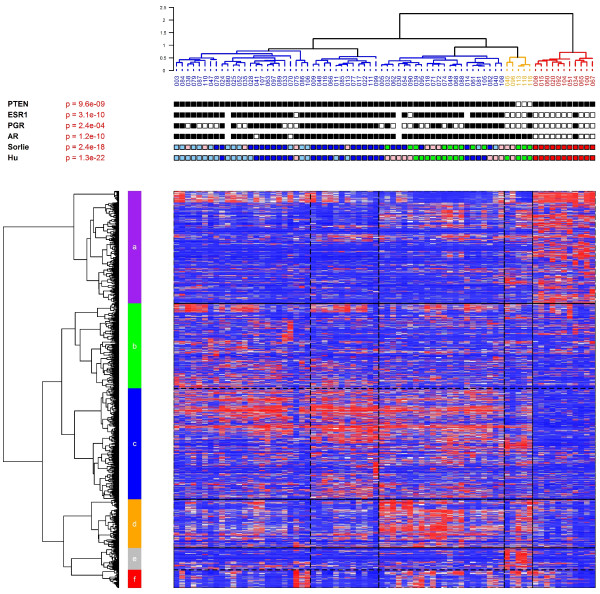
Unsupervised hierarchical clustering of familial breast cancers. Unsupervised hierarchical clustering using 2,447 highly variable probe sets. The orange branch contains the molecular apocrine tumors and includes the three Cowden tumors. PTEN: Germline PTEN mutation status (black box: wild type; white box: mutated). ESR1, PGR, AR: estrogen, progesterone and androgen receptor status determined by immunohistochemical staining [black box: positive (that is, score 2); white box: negative (that is, score 0 and 1 - see material and methods)]. Sorlie: The colored boxes represent the Stanford intrinsic gene classification based on the centroids described by Sorlie et al. [4] (red, basal-like class; pink, HER2 class; green, normal-like class; dark blue, luminal A class; light blue, luminal B class). Hu: same classification based on the revised centroids [2].